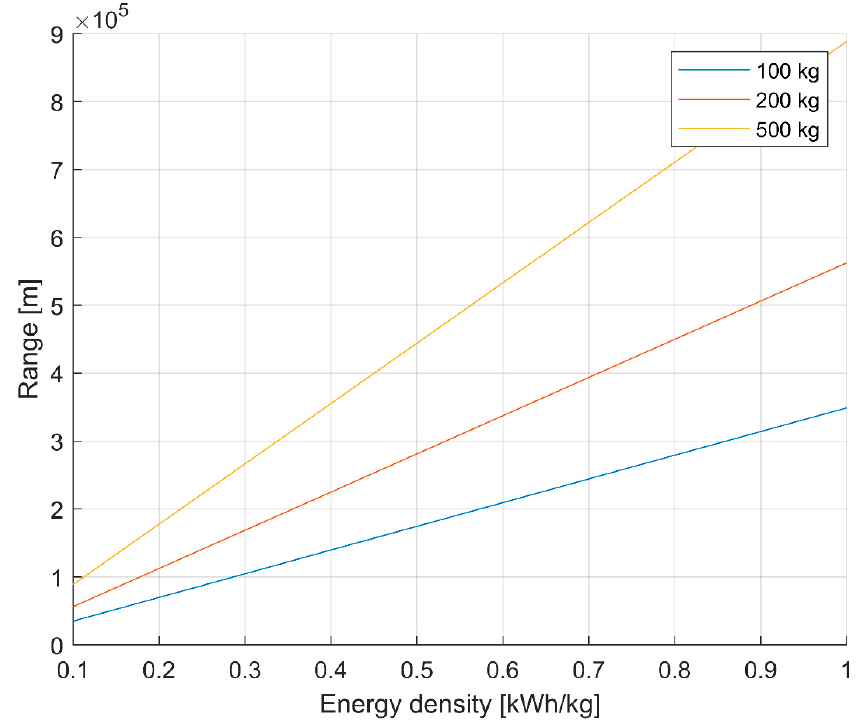
Figure 4. Energy density range influence.